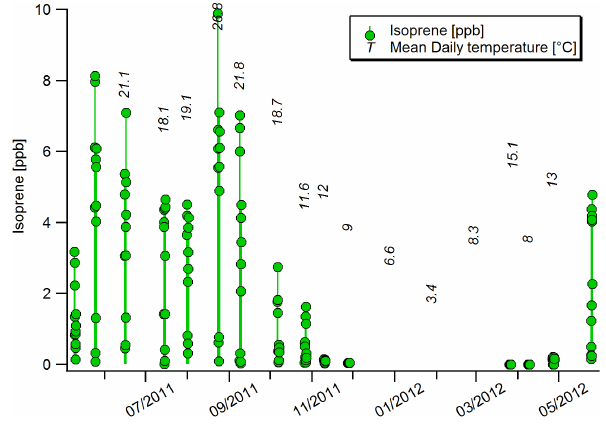
Figure 1. Seasonal variation of isoprene concentrations (3ma.g.l.) at the O 3 HP, May to December 2011 and from April to June 2012. Measurement derived from cartridge samples and analysed by GC-